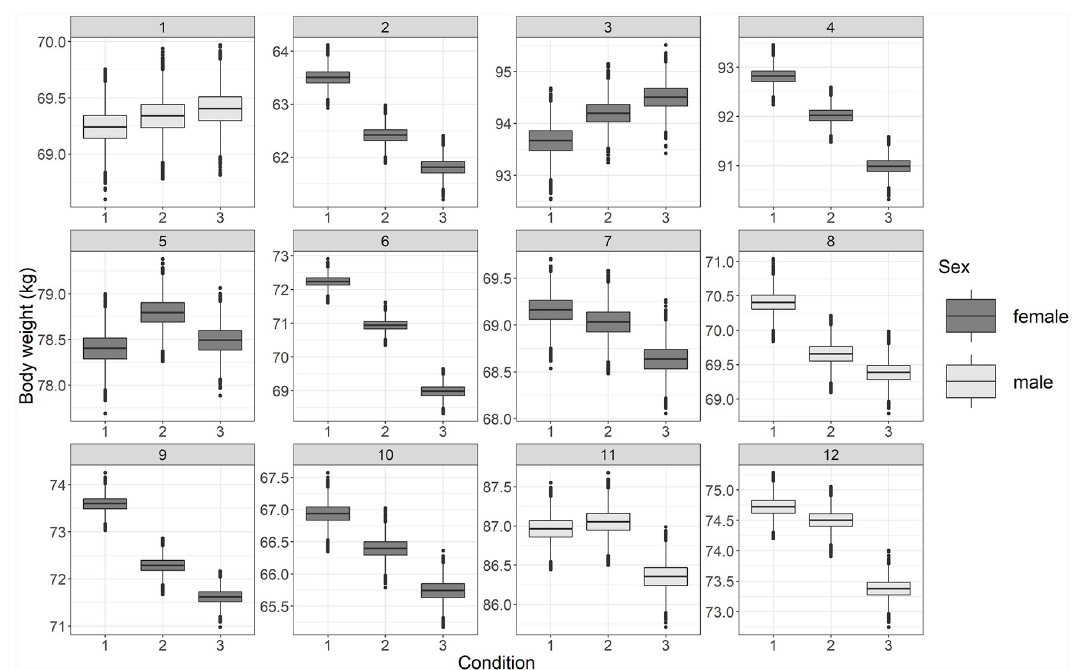
Fig 6. The estimated body weight over the three periods for each